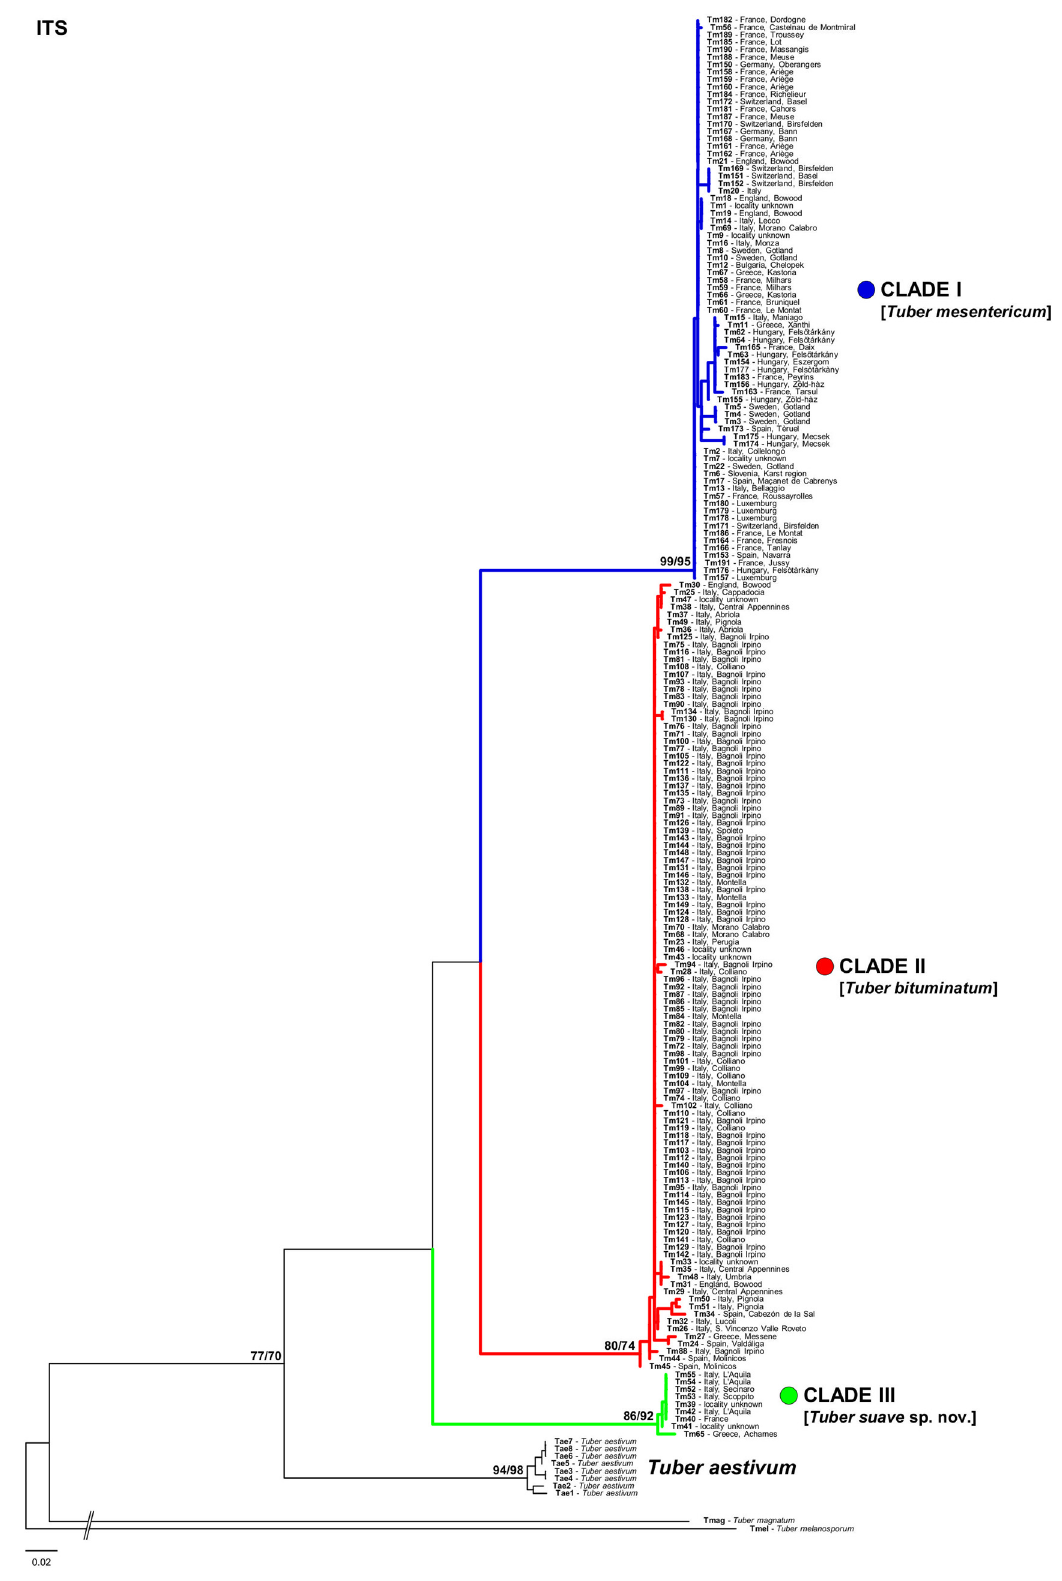
Figure 2. Phylogeny of T. mesentericum complex, based on the ITS rDNA dataset. Bootstrap (BS) and rapid bootstrap (rBS) values (>70) are reported on nodes. Specimens are labelled by their geographic origin and ID, listed in Tables 1 and S1.